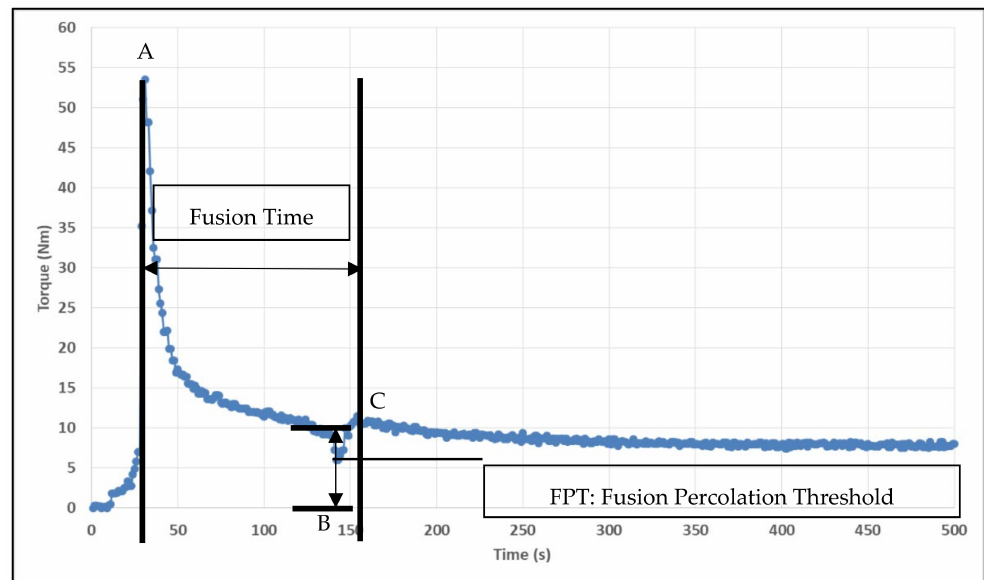
Figure 2. General fusion curve of unfilled ABS compound melted in Haake internal Mixer at a temperature of 190 ◦ C, with the speed of 90 rpm at 15 min of blending